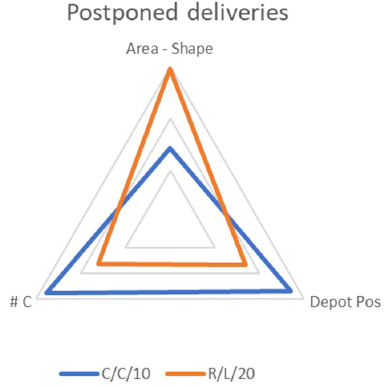
Figure 5. Postponed deliveries.